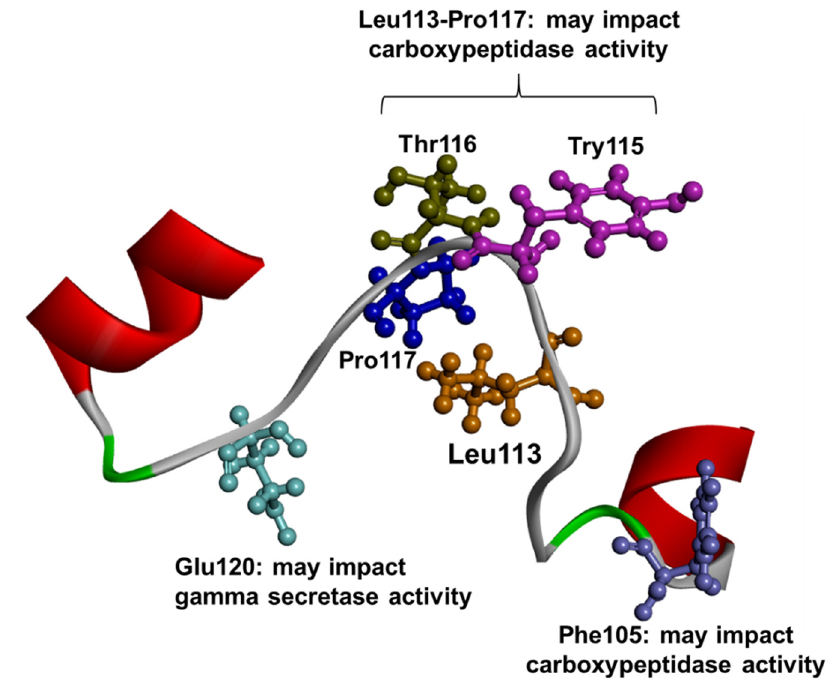
Figure 4. Residues in HL1 which may be critical in γ -secretase production .